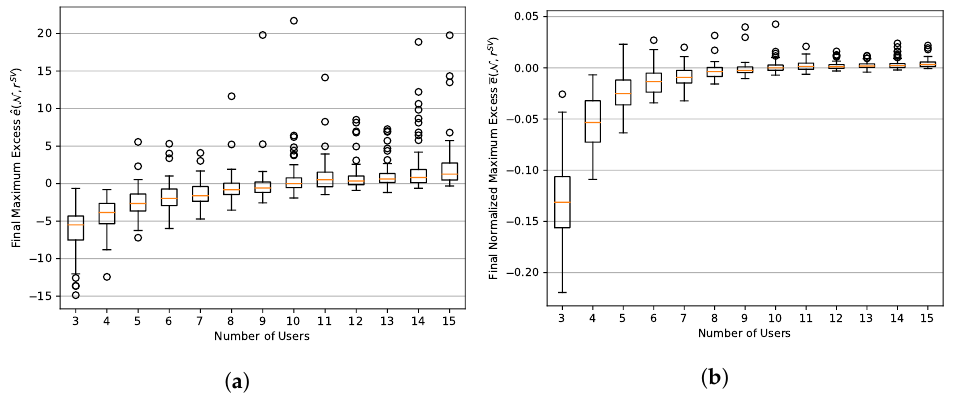
Figure 4. Boxplot of final maximum excess ( a ) and normalized maximum excess ( b ) with Shapley value in 1000 trials broken down by the number of users in the